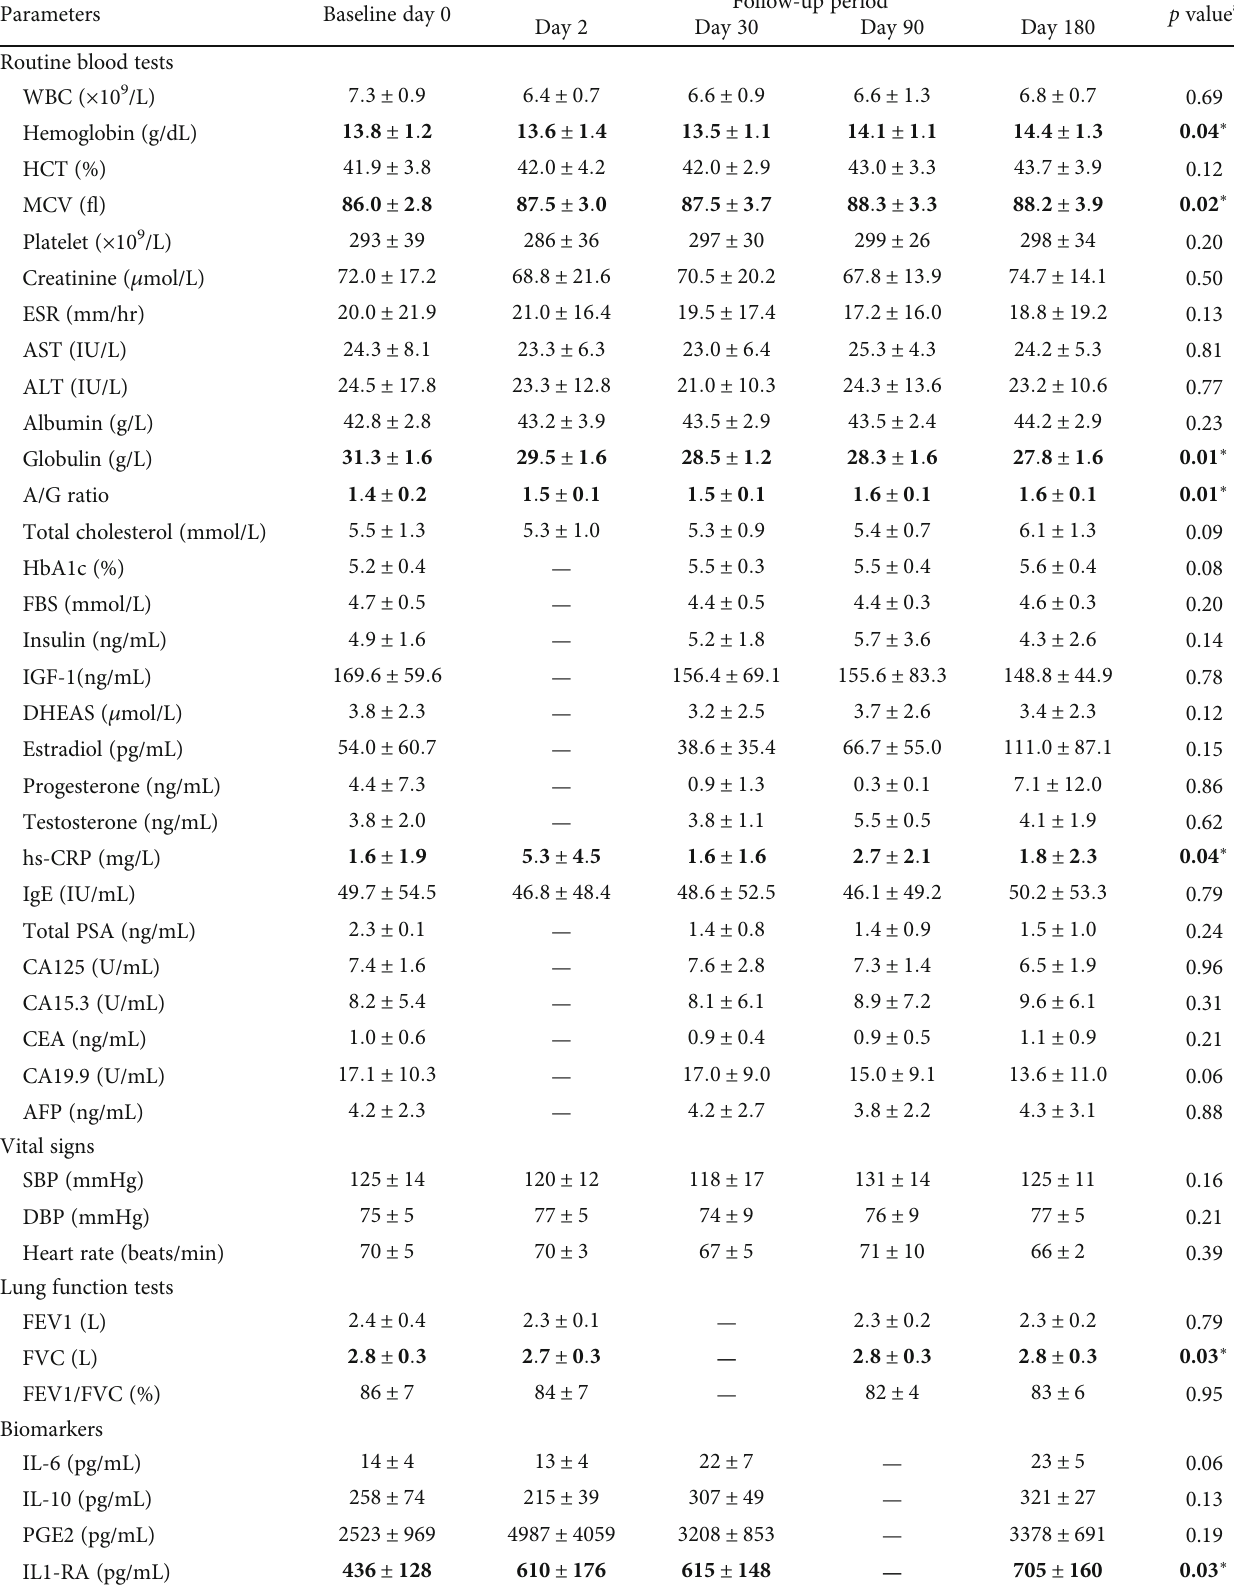
Table 4: Baseline and follow-up clinical assessments among subjects in the HD